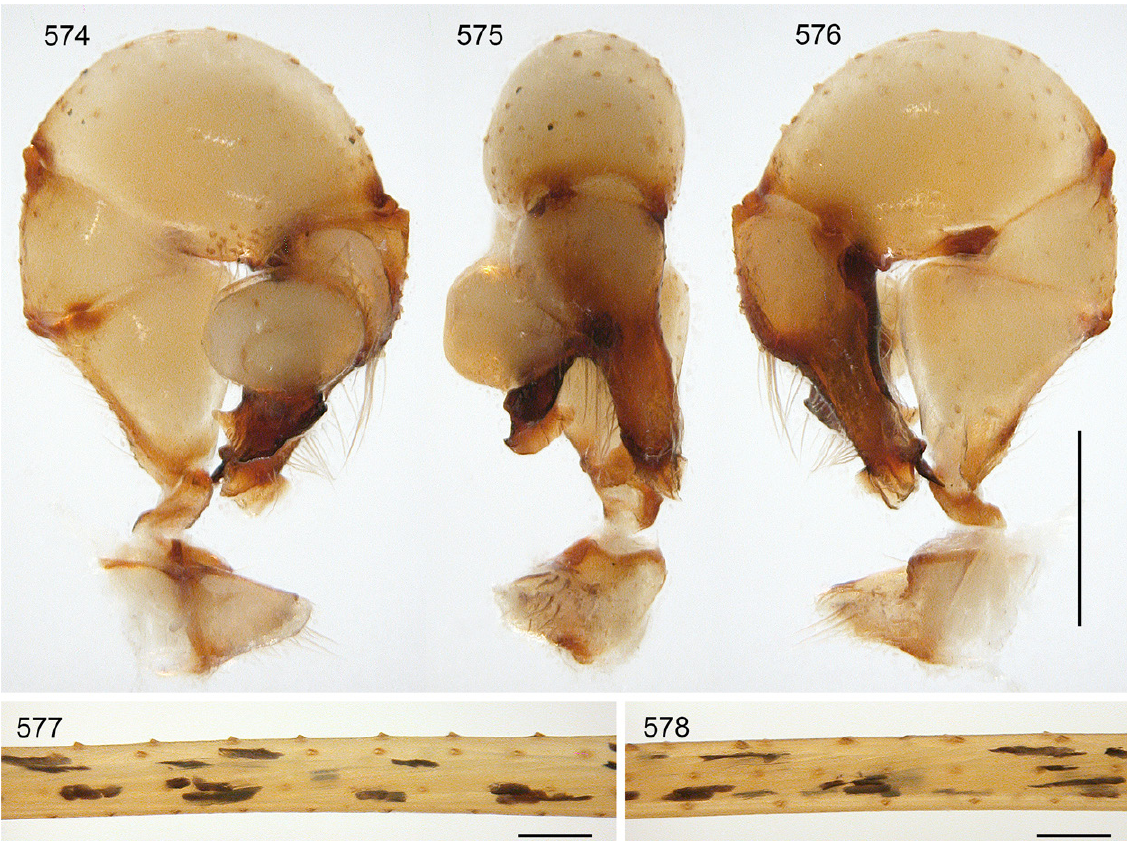
Figs 574–578. Crossopriza semicaudata (O. Pickard-Cambridge, 1876); male from Egypt, 5 km N of Aswan (CAS 9027139), and female from Egypt, Luxor (SMF). 574–576 . Left male palp, prolateral, dorsal, and retrolateral views. 577–578 . Female right femora 2 and 3, dorsal views. Scale bars: 574– 576 = 0.5 mm; 577–578 = 0.2